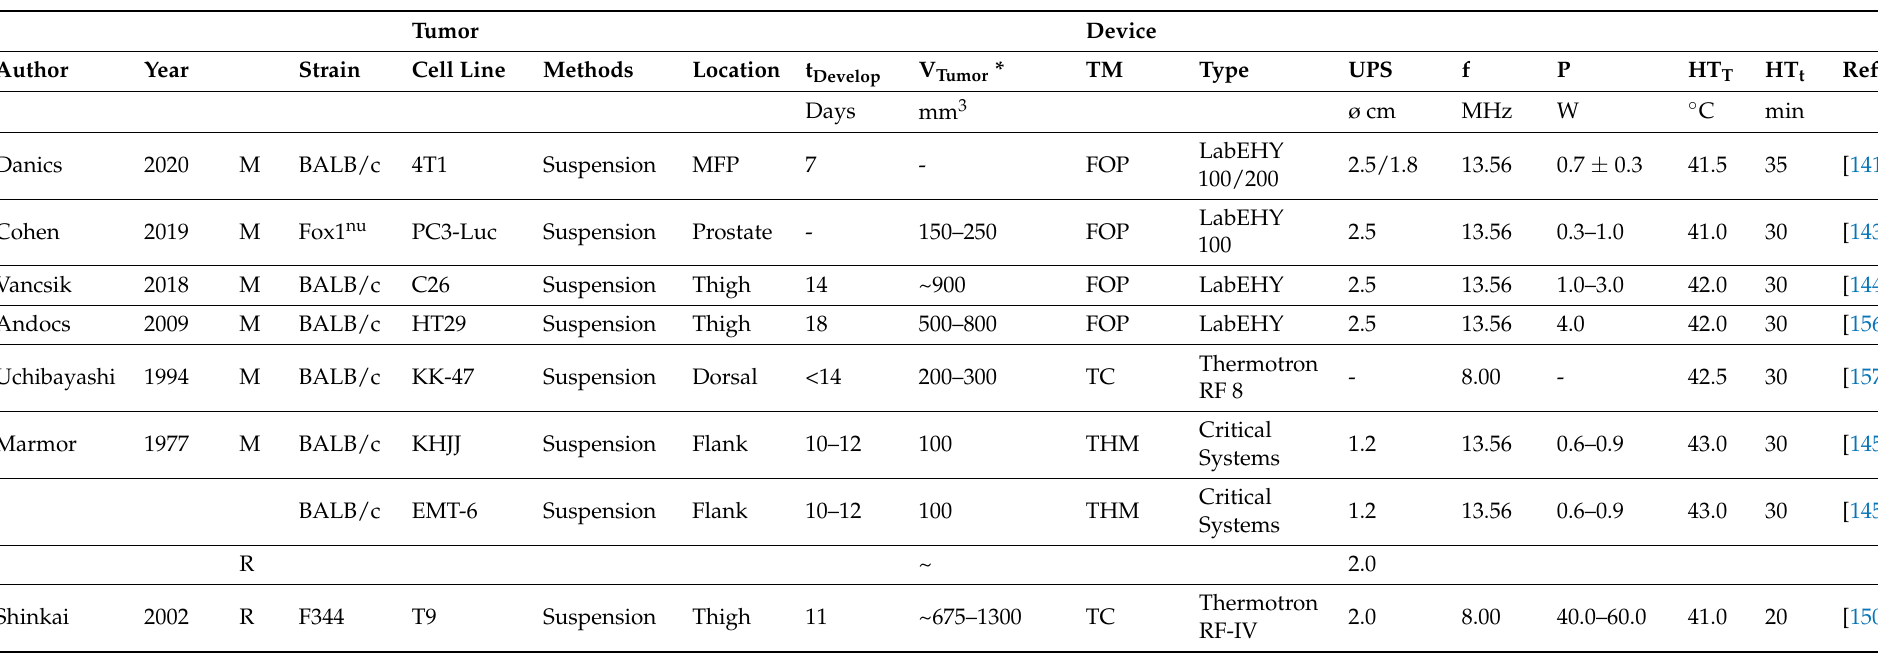
Table 5. Overview of the preclinical studies on application of local hyperthermia using capacitive hyperthermia sorted by year of publication and animal